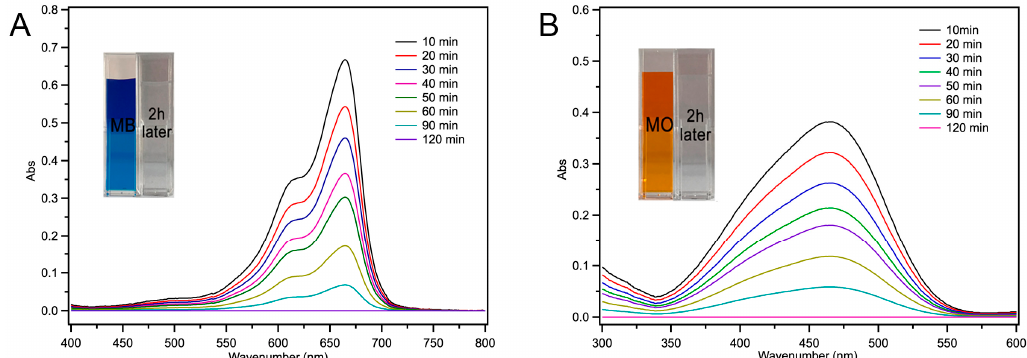
Figure 7. UV-Vis absorption spectra of Fe-loaded MOF-545(Fe) degrading MB ( A ), MO ( B ) with H 2 O 2 ; each sample was diluted 2.5 times before UV-Vis absorption spectra measurements. The graph shows the color change before and 2 h after degradation process.